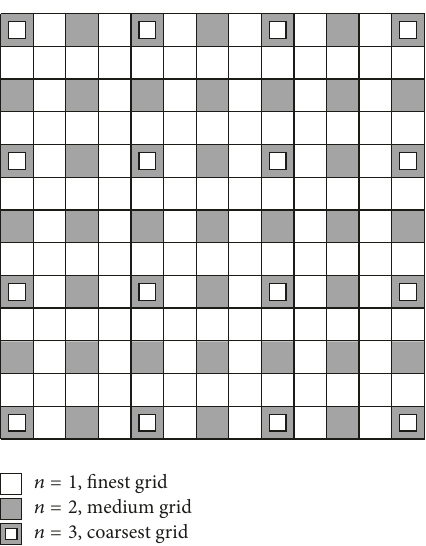
Figure 3: Example of the template using three multiple grids (after Remy et al.